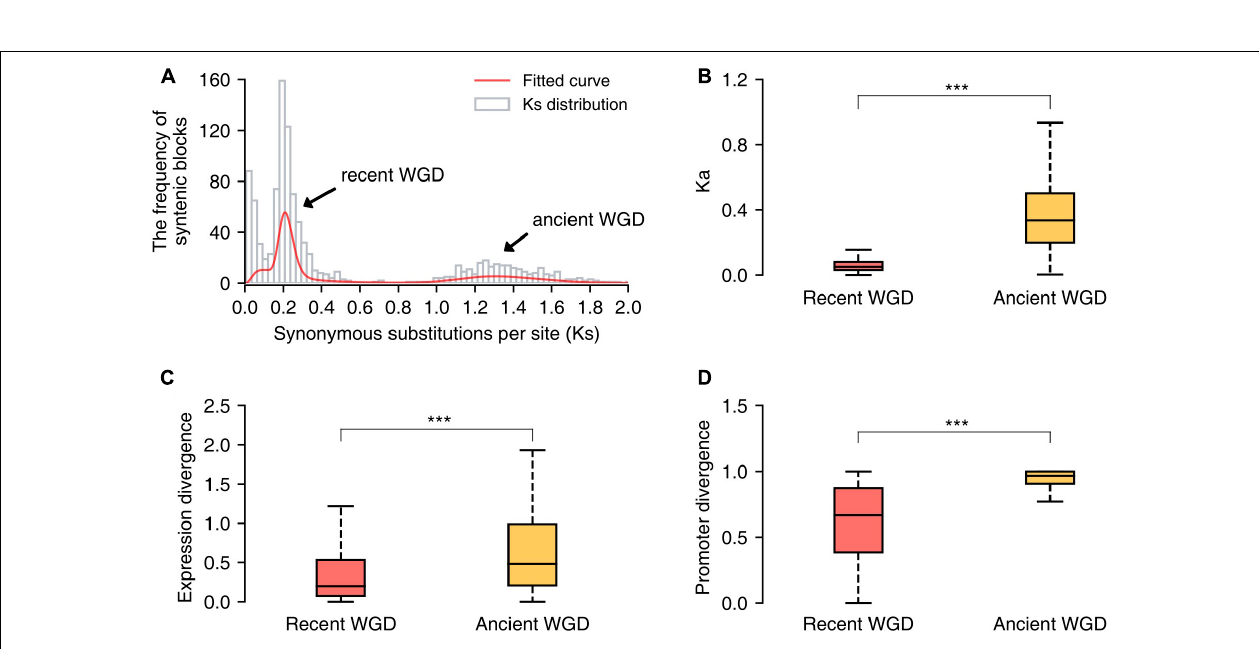
Frontiers in Plant Science |